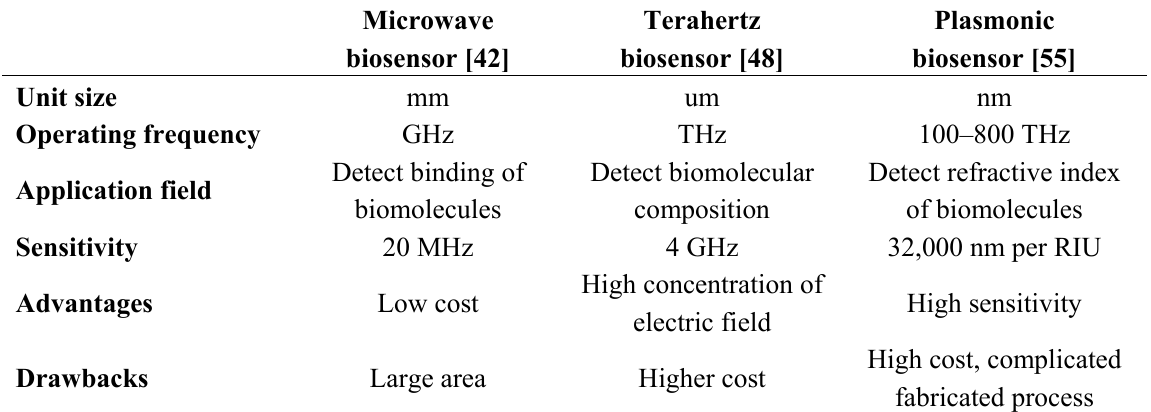
Table 1. Detailed comparative results of three